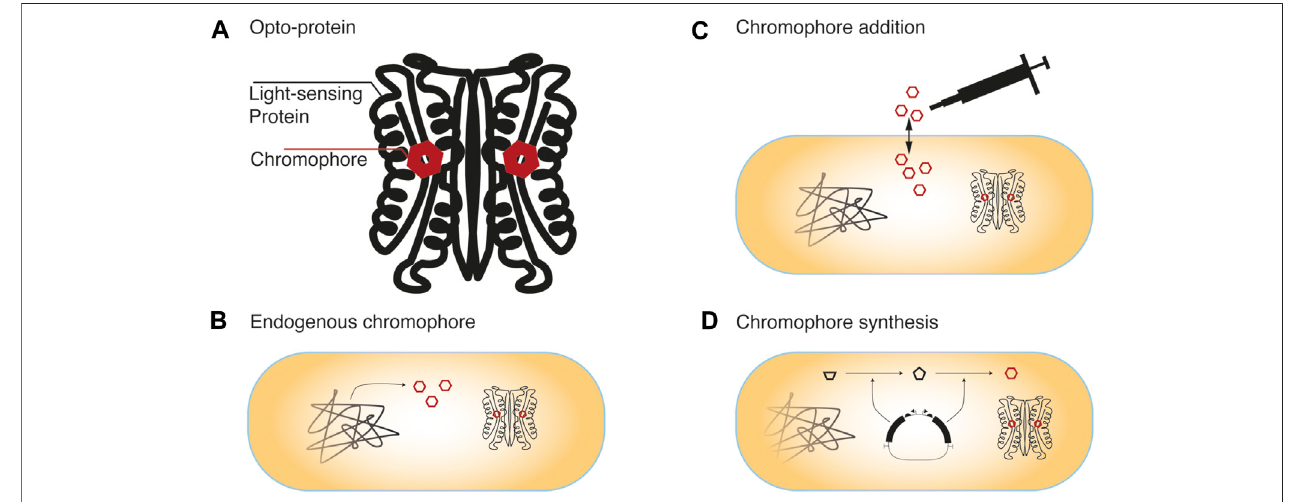
FIGURE 1 | Chromophore availability in cells (A) Light sensing proteins contain either light-absorbing tryptophane conformations or bound small-molecule chromophores (B) Depending on the host organism and the photosensitive protein, the chromophore might be available in the cell through its native metabolism. Otherwise, availability of the chromophore can be realized through (C) external supplementation of the chromophore or its precursors, which requires their diffusion or active uptake into the cell, or by (D) transferring the genes necessary for its synthesis into the cells of